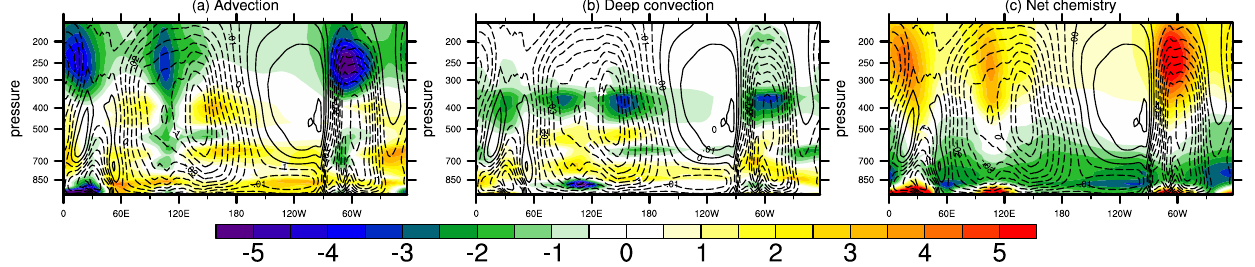
Figure 2. Vertical profile of the tropospheric climatology of the three major tendency terms (color, in ppbday − 1 ) for boreal winter (November–April) averaged between 10 ◦ S and 10 ◦ N: advection (a) , deep convection (b) and net chemistry (c) with vertical velocity (dashed lines denote negative values/upward motions and solid lines represent the positive values/downward